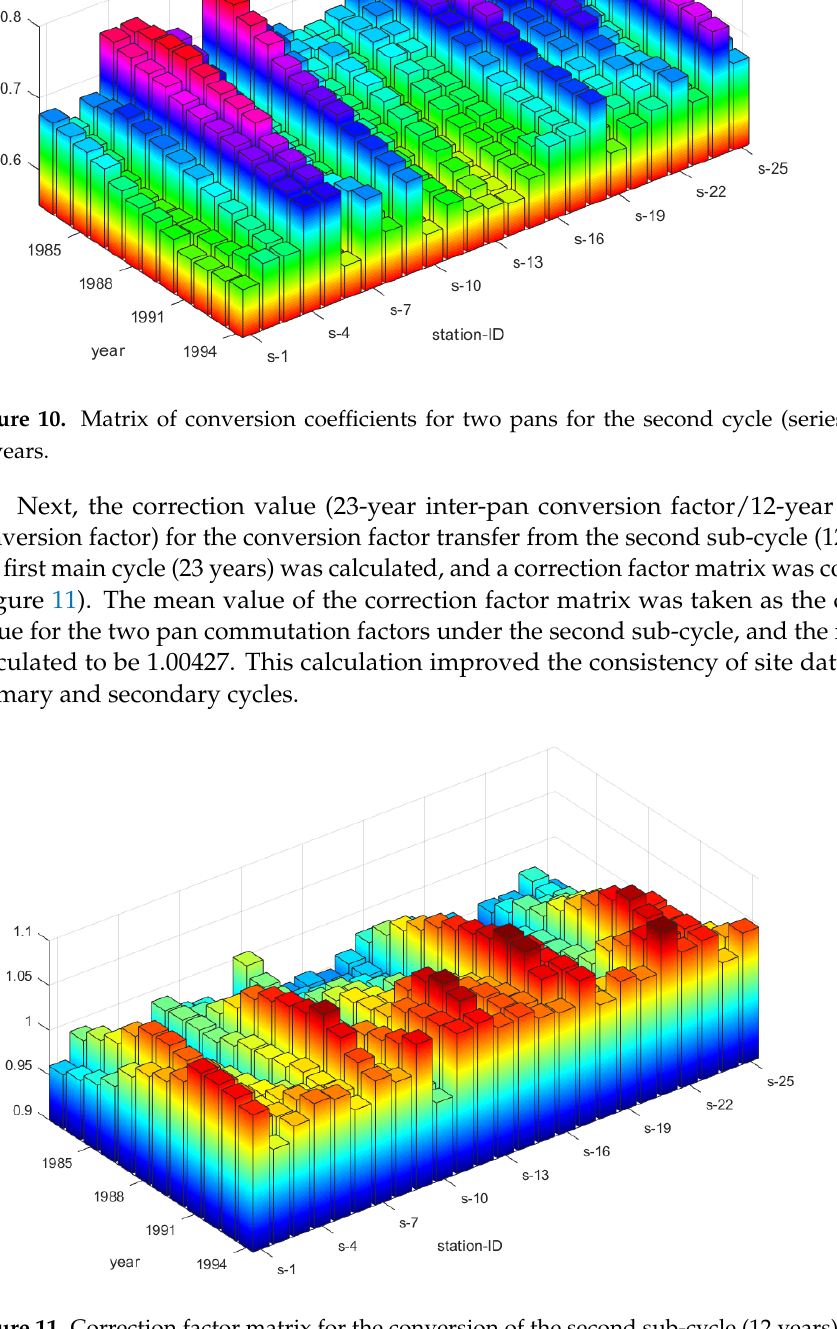
Figure 11. Correction factor matrix for the conversion of the second sub-cycle (12 years) to the first main cycle (23